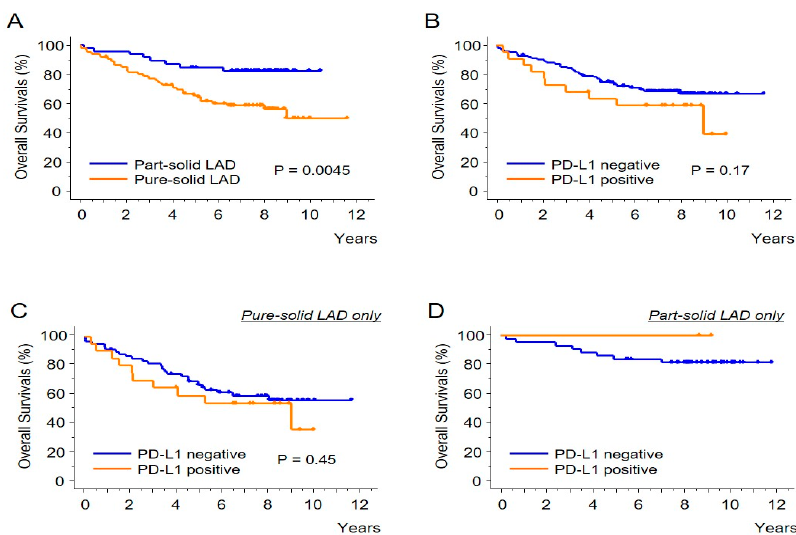
Figure 3. The Kaplan-Meier curves showing the overall survivals. Comparisons of the part-solid LADs versus the pure-solid LADs ( A ) and PD-L1 positive tumors (1% or higher) versus negative tumors ( B ) are shown. The prognostic impact of PD-L1 expression status was also analyzed in pure-solid LADs ( C ) and in part-solid LADs ( D ).